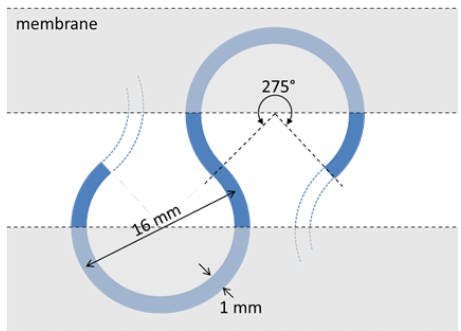
Figure 8. Top view scheme of the geometry of the meander-shaped micro channel and the relative position of the two membrane areas.